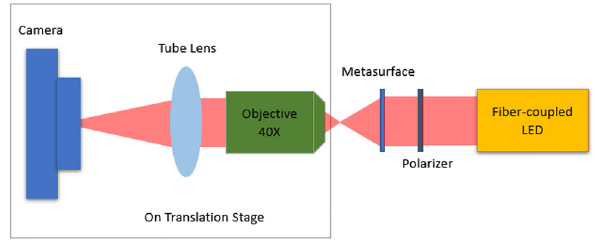
Figure 5: Confocal microscopy setup used to measure the metalenses.